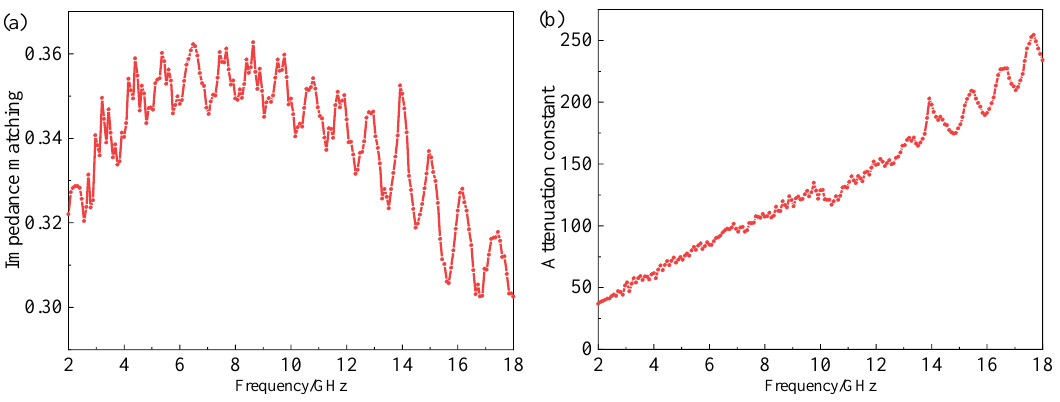
Figure 9. ( a ) Impedance matching and ( b ) attenuation constant of the CB20 − CIP30 composite.